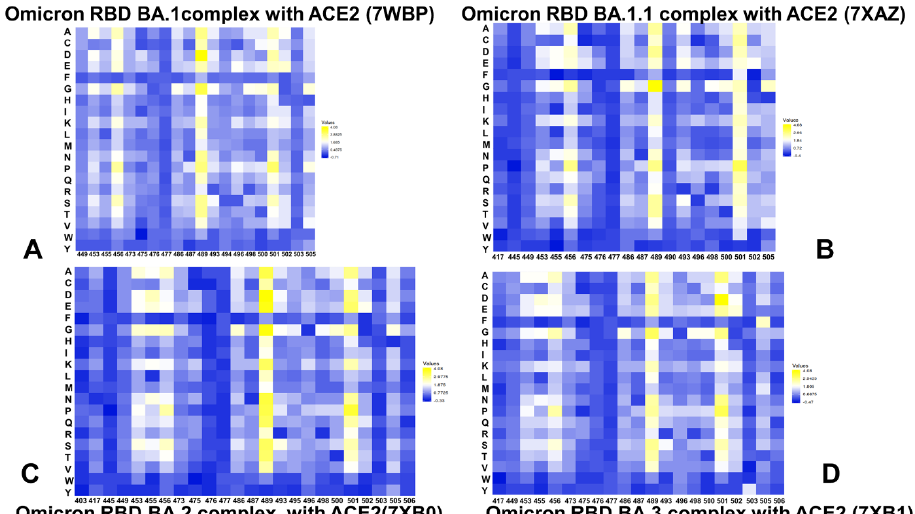
Figure 7. Ensemble-based dynamic mutational profiling of the RBD intermolecular interfaces in the Omicron RBD-hACE2 complexes. The mutational scanning heatmaps are shown for the interfacial RBD residues in the Omicron RBD BA.1-hACE2 ( A ), Omicron RBD BA.1.1-hACE2 ( B ), Omicron RBD BA.2-hACE2 ( C ), and Omicron RBD BA.3-hACE2 complexes ( D ). The heatmaps show the com- puted binding free energy changes for 20 single mutations of the interfacial positions. The cells in the heatmap are colored using a 3-colored scale—from blue to white and to yellow, with yellow indicating the largest unfavorable effect on binding. The standard errors of the mean for binding free energy changes were based on MD trajectories and selected samples (a total of 1000 samples) are within ~0.08–0.2 kcal/mol using averages over 10 different MD trajectories. Mutational scanning of the RBD residues in the Omicron RBD BA.2 complex high- lighted a larger binding interface, in which the mutation-induced destabilization is dis- tributed over more residues (Figure 7C). The large destabilization changes become more pronounced for Y453, L455 and F456 while also revealing highly sensitive positions for F486, N487, Y489, R493, T500, Y501, and H505 (Figure 7C). The difference in the RBD– ACE2 interface for the BA.1 and BA.2 variants are the two residues located at residue positions 446 and 496, which are S446 and S496 for BA.1 and G446 and G496 for BA.2. While S496 makes interaction contacts with D38 and K353, G496 makes contacts with D38 in the BA.2 complex. Interestingly, mutational scanning in S496 position in the RBD BA.1 and BA.1.1 complexes revealed moderate destabilization changes in the range ΔΔ G = 0.3– 1.5 kcal/mol, where S496G mutation is destabilizing with ΔΔ G = 0.63 kcal/mol for the BA.1 complex and ΔΔ G = 0.48 kcal/mol for the BA.1.1 complex (Figure 7C). At the same time, mutations of G496 in the BA.2 complex showed larger destabilization changes than corre- sponding modifications of S496 in the BA.1.1 complex. In particular, the reversed G496S mutation is more destabilizing in the BA.2 complex with ΔΔ G = 0.88 kcal/mol than the respective S496G mutations in the BA.1 and BA.1.1 variants. Based on structural observa- tions, it was suggested that the S496G site mutation could contribute to ~3.6-fold affinity increase, whereas the G496S mutation in BA.2 RBD may induce ~1.5-fold decrease in hACE2 binding affinity [38]. Our analysis showed that both S496 and G496 sites make